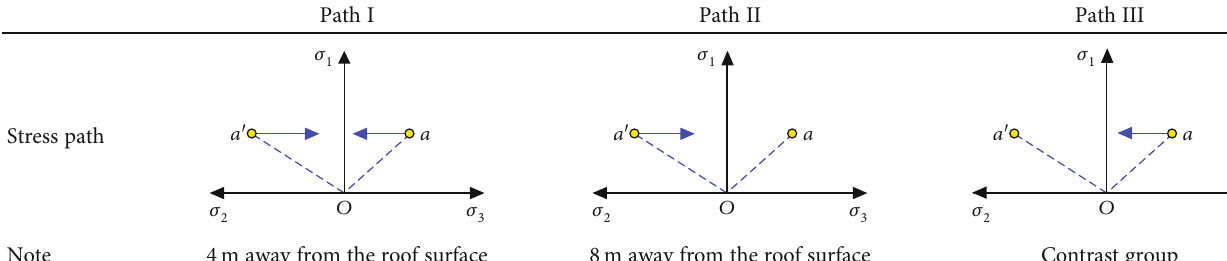
Figure 7: Variation of the angle between the principal stress and the vertical direction. Table 2: Typical stress paths.